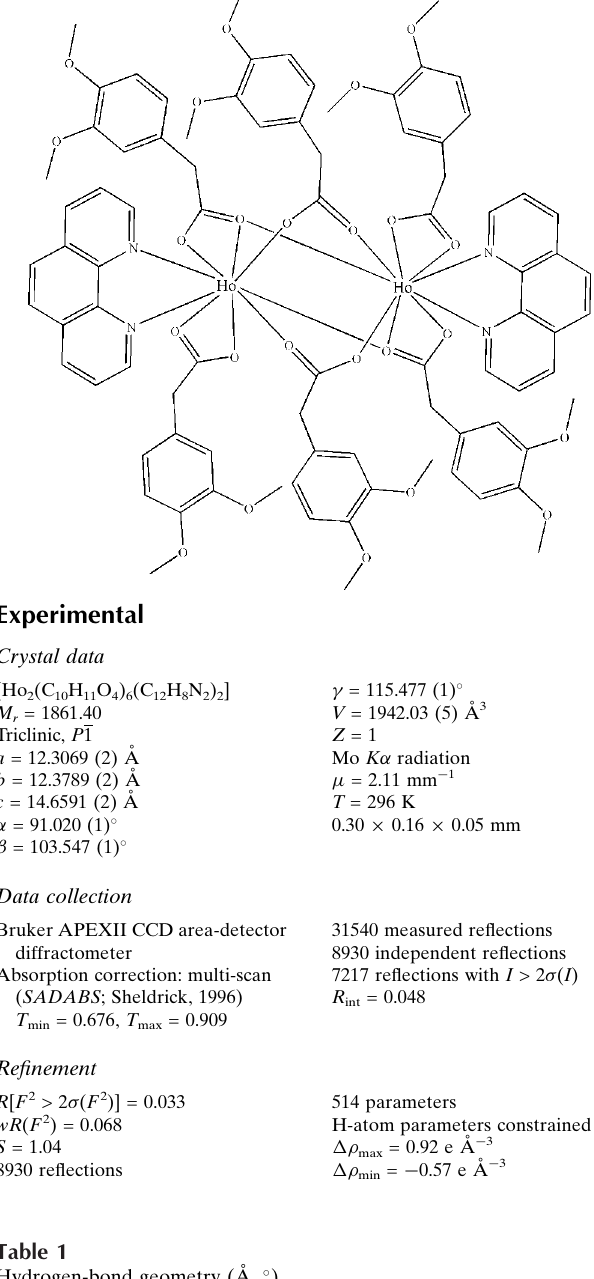
Hydrogen-bond geometry (A˚ , (cid:3) ). D —H (cid:2)(cid:2)(cid:2)